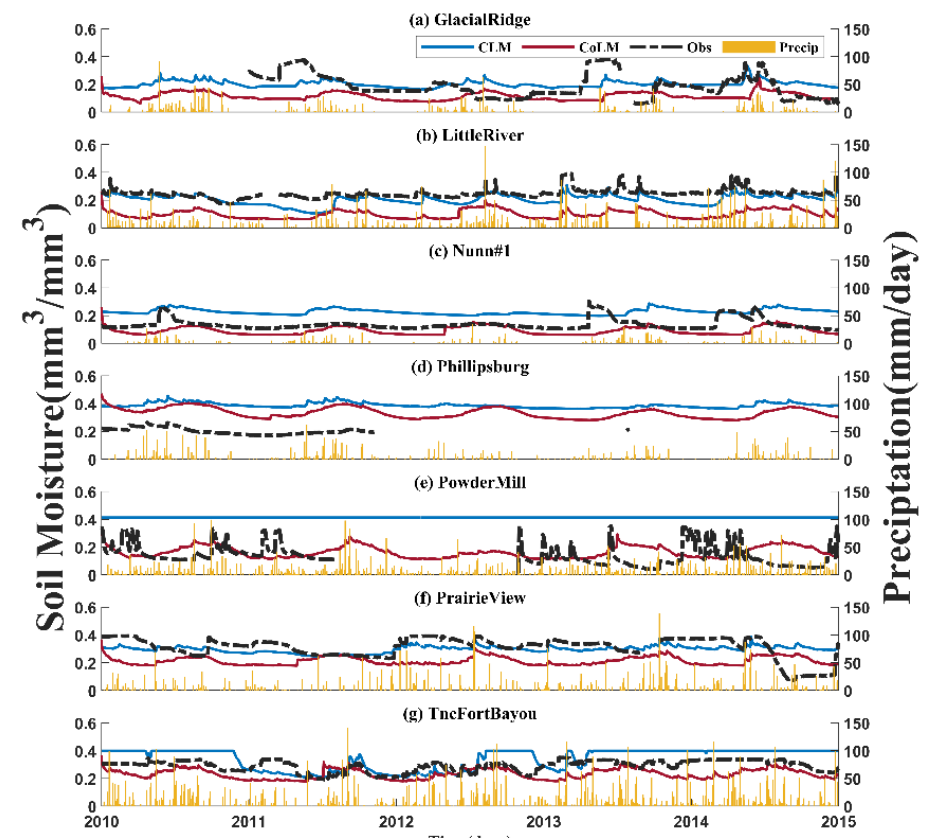
Figure 5. Simulated and observed temporal soil moisture variation values at the SCAN sites for 2010 – 2014 at a soil depth of 0.5080 m. The blue line is the CLM5 simulation, the red line is the CoLM2014 simulation, the dashed line is the observations, and the yellow bars are the daily cumu- lative precipitation. ( a – g ) Glacial Ridge, Little River, Nunn#1, Phillipsburg, Powder Mill, Prairie View, and Tnc Fort Bayou, respectively.